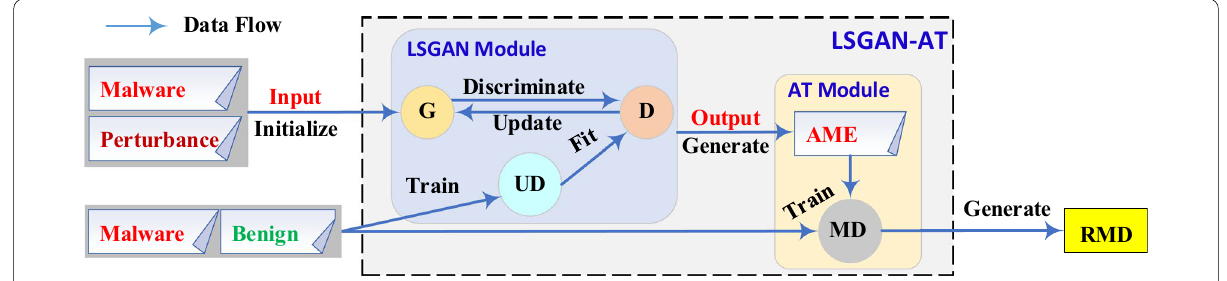
Fig. 3 The overall structure of